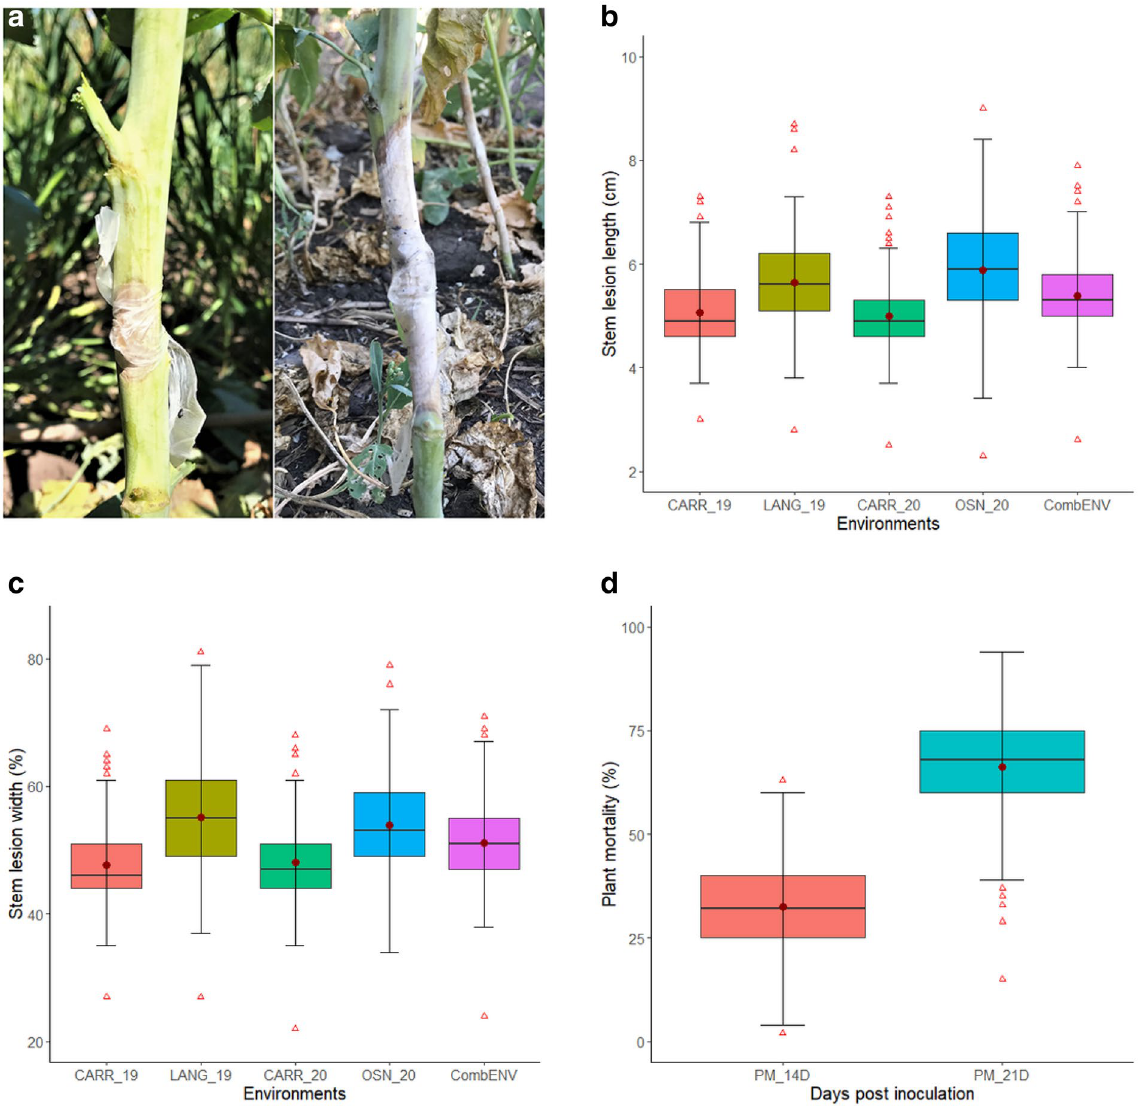
Figure 1. Average disease phenotypic characteristics of 187 Brassica napus genotypes evaluated at Carrington in 2019 (CARR_19) and 2020 (CARR_20), Langdon in 2019 (LANG_19), Osnabrock in 2020 (OSN_20) and combined across four environments (CombENV), North Dakota. Sclerotinia stem rot lesions on the most resistant (left) and susceptible (right) genotypes seven days post inoculation (dpi) ( a ). Boxplots of BLUEs (Best Linear Unbiased Estimates) values for lesion length (cm) measured 7 dpi ( b ); lesion width (%) measured 7 dpi ( c ); and percentages of plant mortality estimated 14 and 21 dpi ( d ). BLUEs for plant mortality are averages of all environments. Box edges represent the upper and lower quartile with median value shown as a bold line in the middle of each box. Mean values are represented by red circle, and the upper and lower whiskers represent the extreme